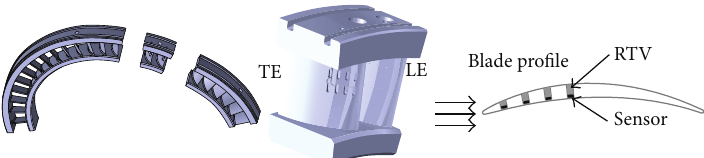
Figure 5: Vane ring modification for accommodation of Kulite sensors.